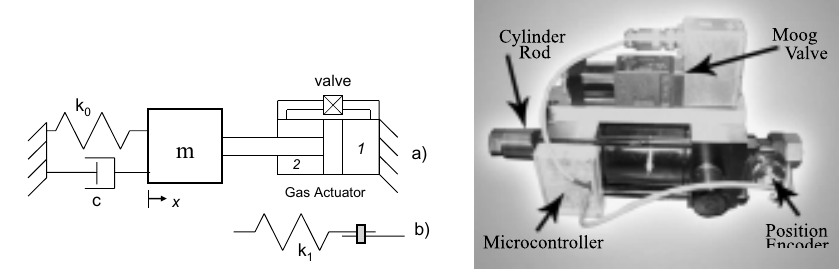
Fig. 1. Model mass-spring-damper system (left) and the hardware that implements resetting control (right). x s , the total energy of the system